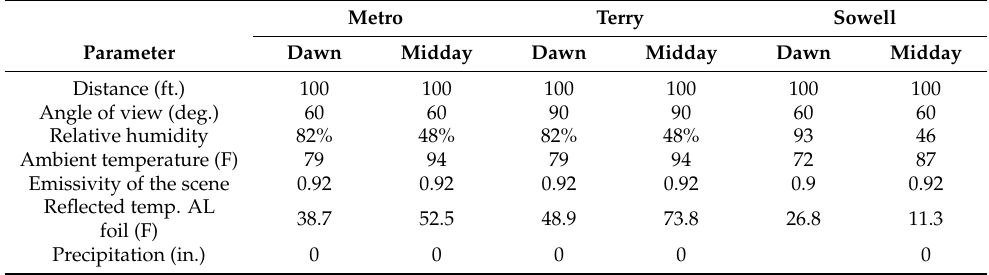
Table 3. TIR image object parameters.